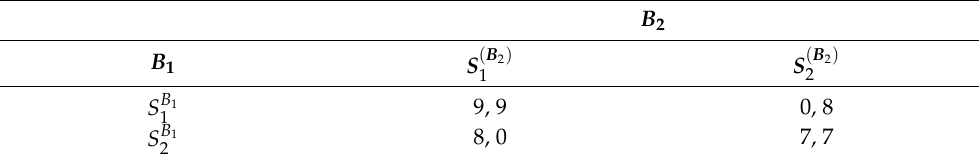
Table 6. Payoff function